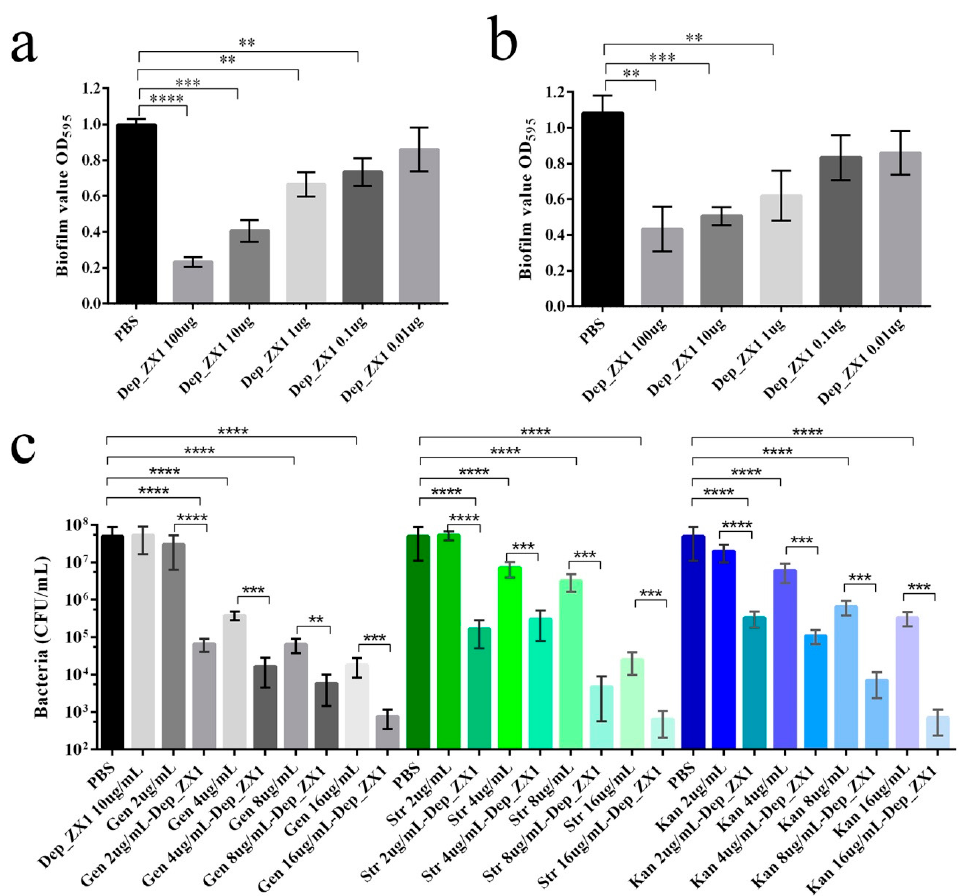
Figure 7. Antibiofilm and antibacterial activity of the depolymerase Dep_ZX1. ( a ) Dep_ZX1 and K. pneumoniae 111-2 was incubated in 96-well plates for 48 h. The biofilm was assessed by crystal violet staining, and the absorbance was measured at 595 nm. ( b ) Biofilm formed by K. pneumoniae 111-2 growth in 96-well plates for 48 h was treated with Dep_ZX1 for 3 h. ( c ) Biofilm formed by K. pneumoniae 111-2 growth in 96-well plates for 48 h was treated with Dep_ZX1 or antibiotics for 2 h. The viable bacterial count was determined on LB agar plates. p < 0.05 (*), 0.01 < p < 0.05 (**), 0.001 < p < 0.01 (***) and p < 0.001(****).